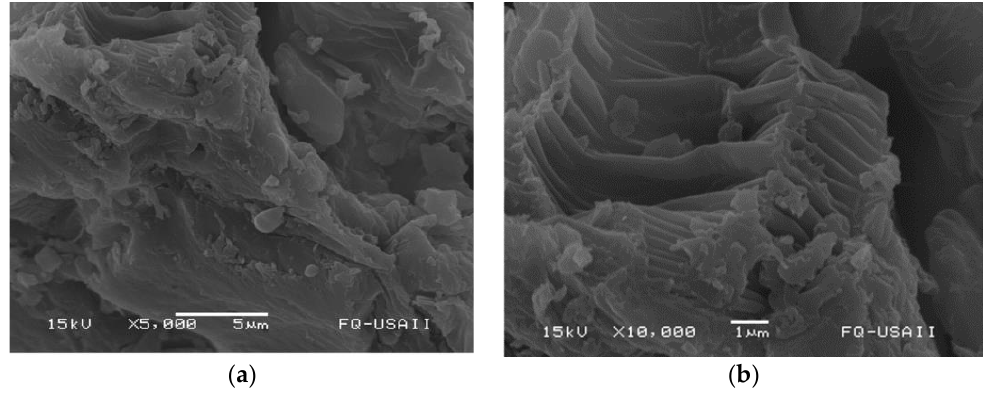
Figure 2. SEM-micrograph of the P. koidzumii sorbent. The upper part of image ( a ) is shown ( b ) at higher magnification.